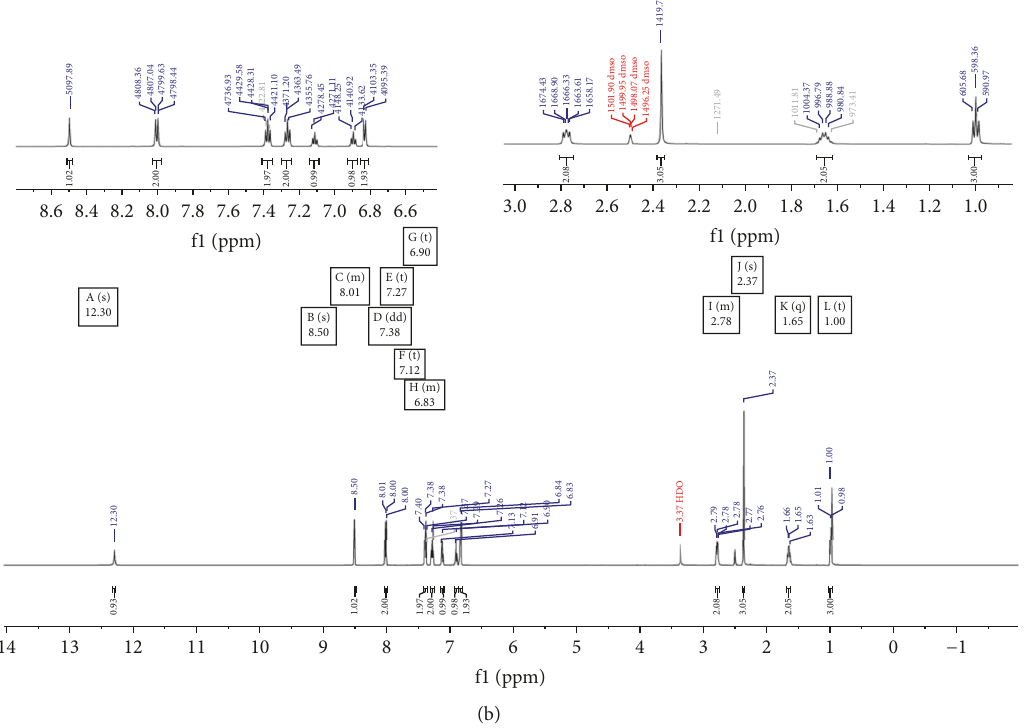
Figure 2: (a) 1 H NMR spectrum of Empp-Ph; (b) 1 H NMR spectrum of